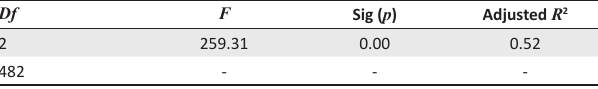
TABLE 6a: Total psychological capital and total innovative thinking combined model.